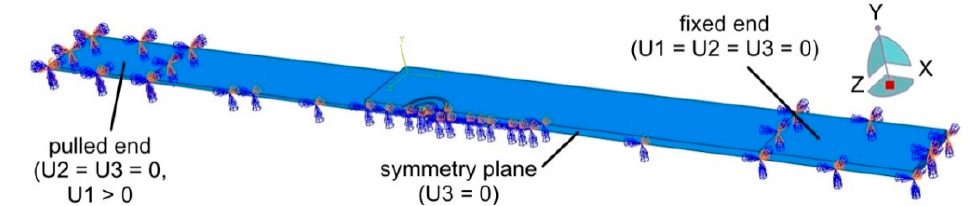
Figure 5. Boundary conditions in the model of the single-lap RFSSW joint.